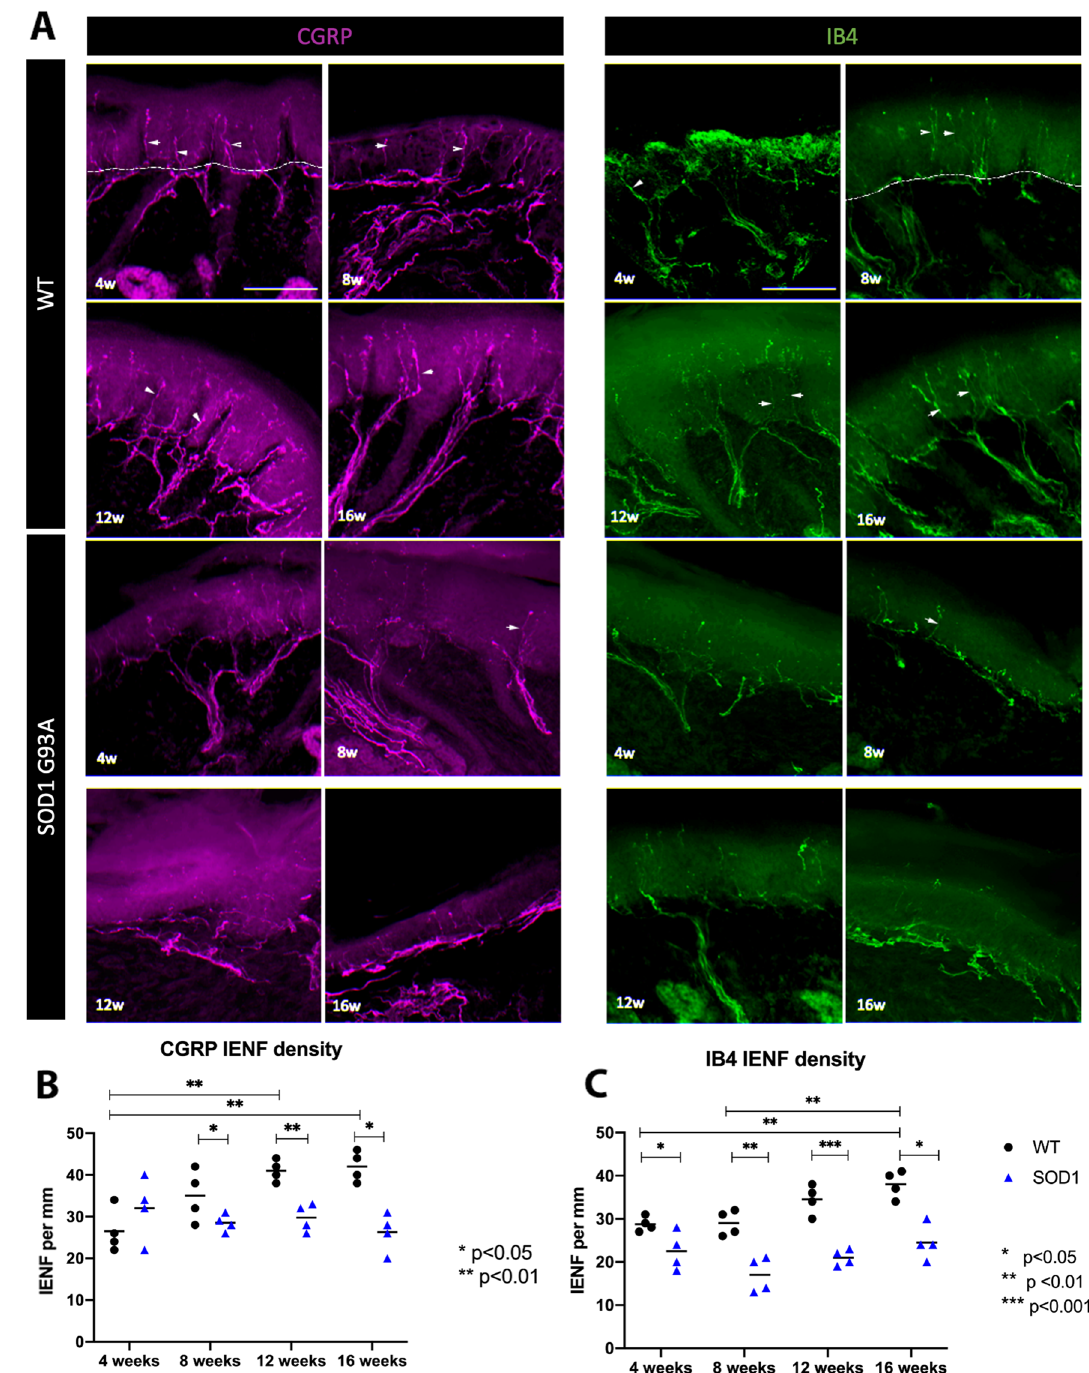
Figure 1. IENF density through time of both sensory epidermal populations in SOD1 G93A mice. ( A ) representative microphotographs of epidermal innervation of CGRP+ and IB4+ fibers of WT and SOD1 mice, at 4, 8, 12 and 16 weeks . Immunofluorescence colours have been adapted for the colour-blind. Scale bar: 100 μm. Arrowheads point to IENF; a dashed line overlies the basement membrane separating dermis and epidermis. ( B ) Plots representing peptidergic (CGRP+) and ( C ) non-peptidergic (IB4+) IENF density. 4 mice WT (black dots) and 4 mice SOD1 G93A (blue triangles) were used in each group. Differences were assessed by two-way ANOVA with post hoc analysis. Both peptidergic and non-peptidergic intraepidermal axons density increase over time in the WT, while in the SOD1 G93A mice remain stable. CGRP+ fibers were significantly lower in SOD1 G93A compared to WT mice at 8, 12 and 16 weeks of age, whereas IB4+ fibers were reduced already at 4 weeks of age. IENF intraepidermal nerve